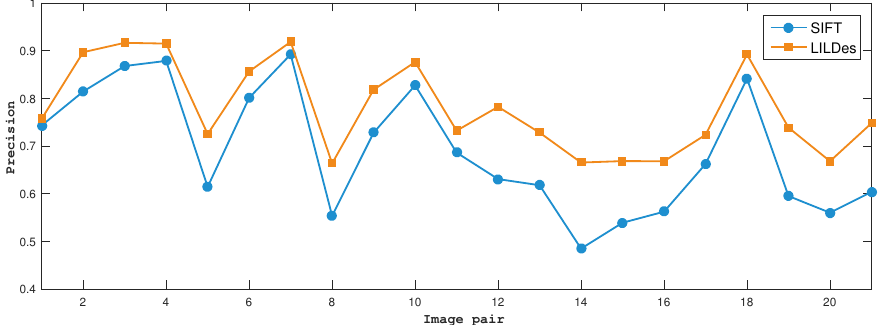
Figure 8. Precisions of matching results using SIFT and LIL descriptors on simulated images.